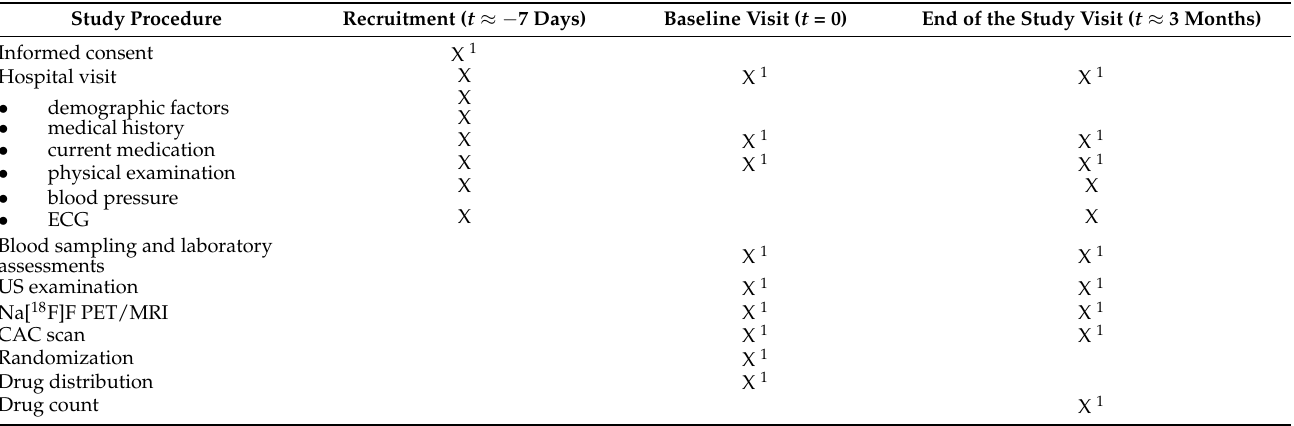
Table 1. Outline of visit